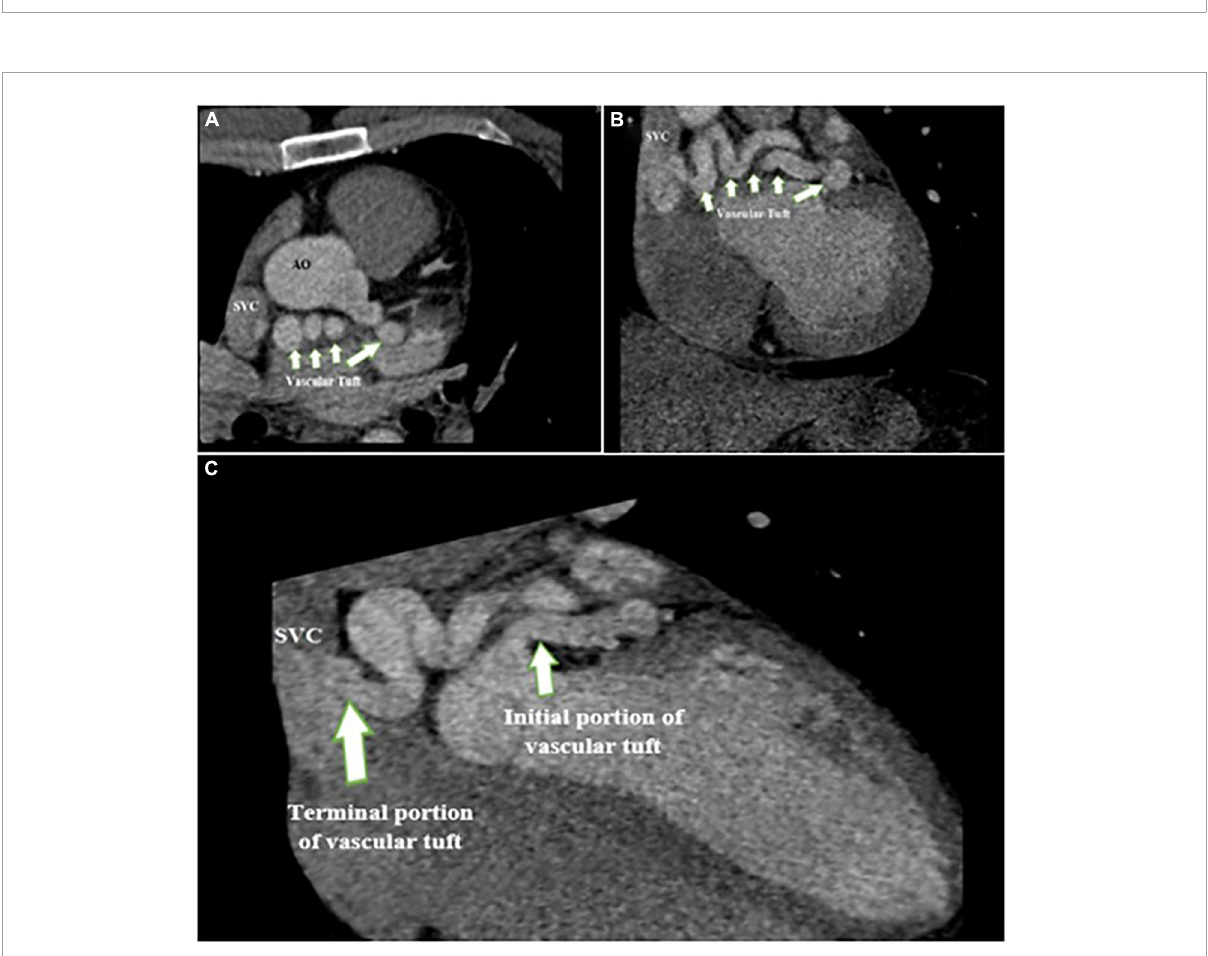
FIGURE6 Contrast-enhanced CT scan of the chest shows the proximal site of giant fistula (white arrow) originating from the left circumflex artery with drainage into the superior vena